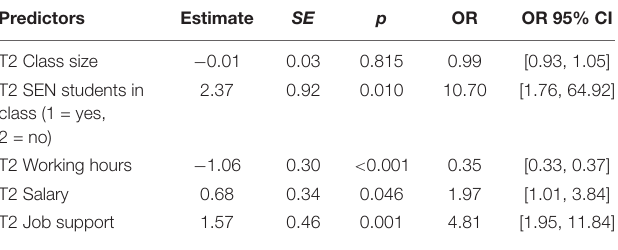
TABLE 5 | Logistic regression of class membership on predictors (with relatively weak well-being – emotional exhaustion as a reference